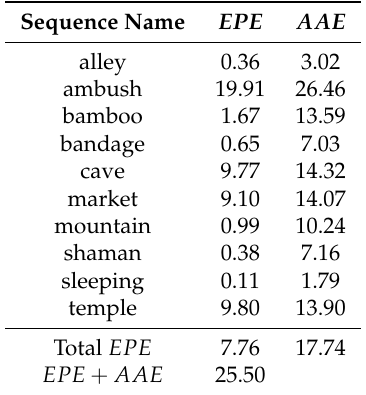
Table 17. Summary of results. The end point error and average angular error obtained by Horn-Schunck in the MPI-Sintel training set.